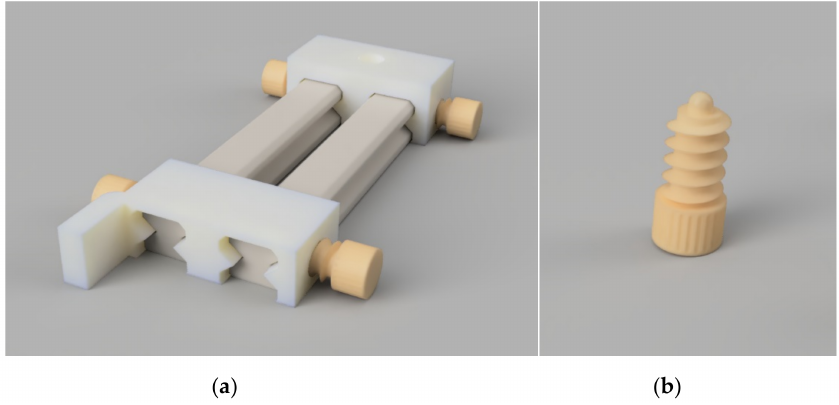
Figure 2. With the above-shown test stand ( a ), the camera position, specimen rotation, and distance to the screen could be adjusted and locked with ball-tip locking screws ( b